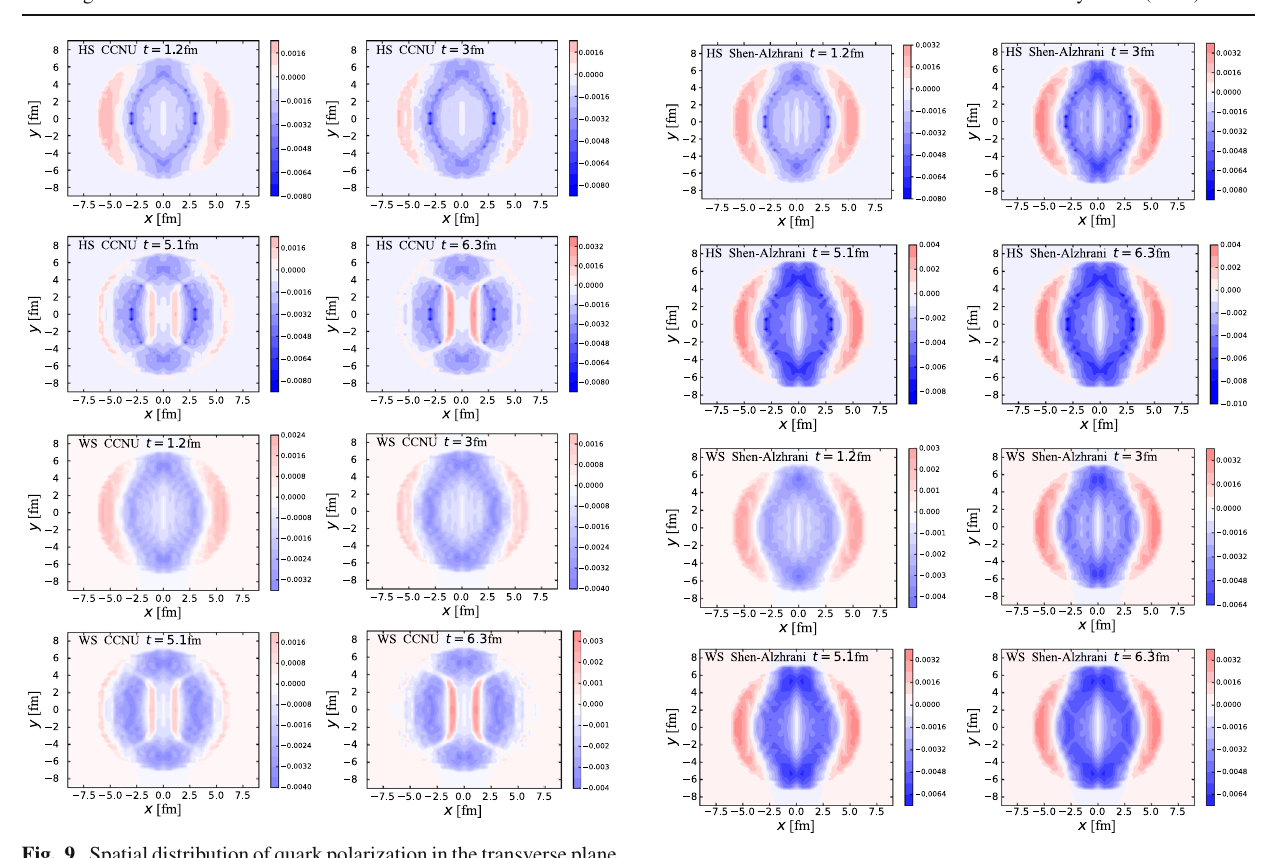
Fig. 10 Spatial distribution of quark polarization in the transverse plane at different times, compared between Hard Sphere (HS) and Woods–Saxon (WS) distributions of the initial nucleon density. The hydrodynamic evolution is initialized with the Shen–Alzhrani